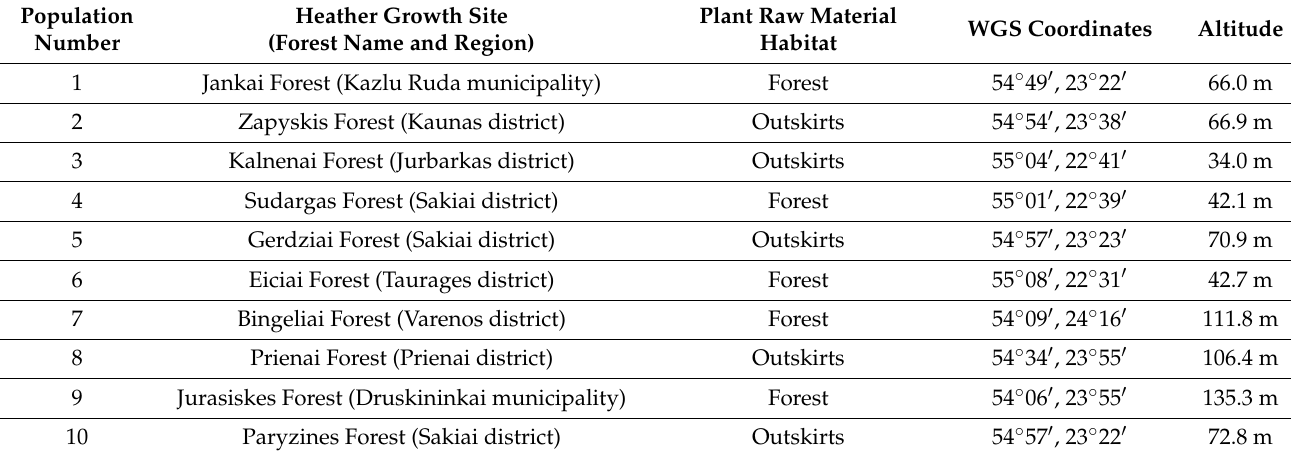
Table 3. Plant raw material habitats of